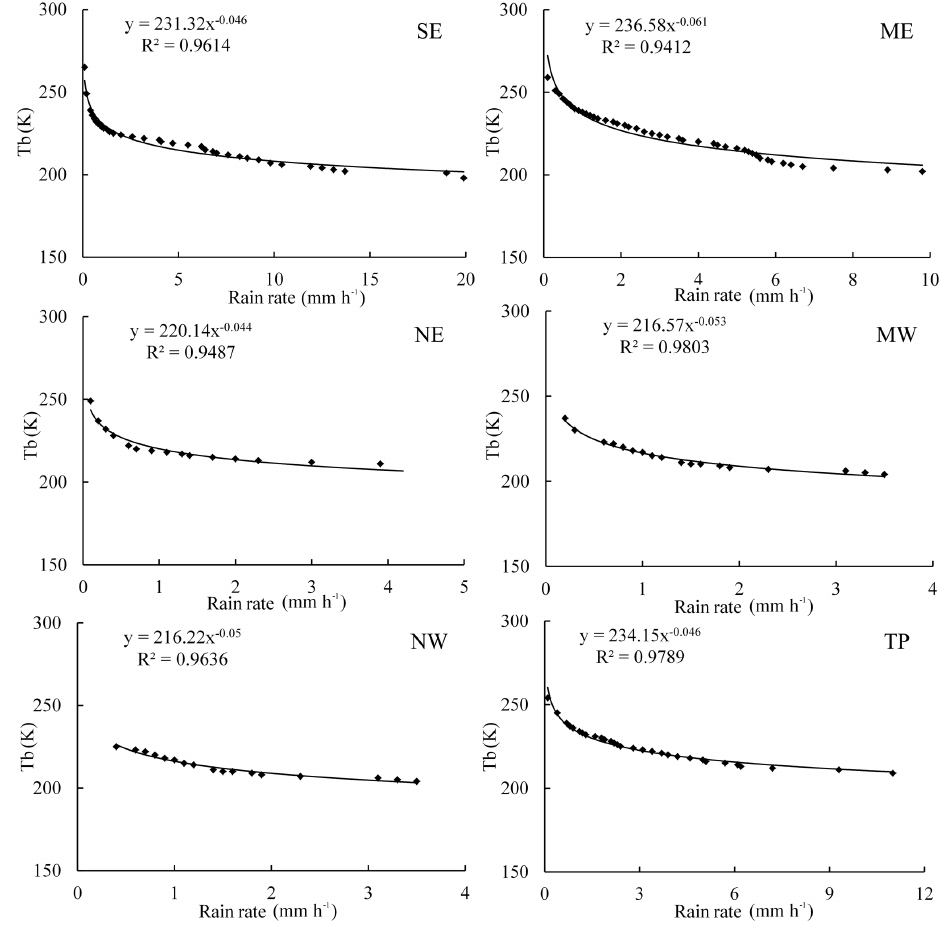
Figure 4. Examples of fitting of the precipitation rate and T b for each region in China during 9–18 July 2014 for subregion SE (115 ◦ 35 (cid:48) E, 27 ◦ 28 (cid:48) N), subregion CE (115 ◦ 39 (cid:48) E, 36 ◦ 14 (cid:48) N), subregion NE (124 ◦ 20 (cid:48) E, 51 ◦ 42 (cid:48) N), subregion CW (101 ◦ 38 (cid:48) E, 37 ◦ 31 (cid:48) N), subregion NW (85 ◦ 43 (cid:48) E, 46 ◦ 47 (cid:48) N) and subregion TP (91 ◦ 06 (cid:48) E, 30 ◦ 29 (cid:48)